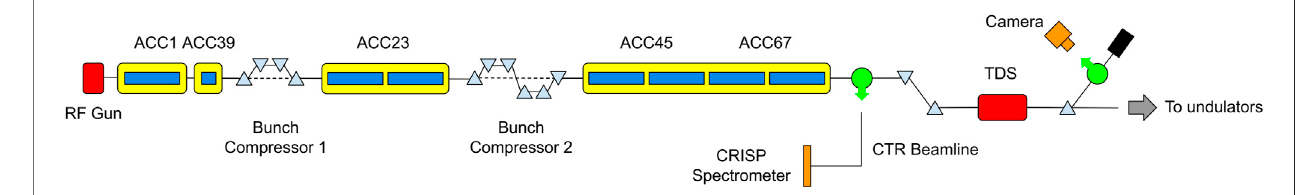
FIGURE 2 | Schematic of the FLASH1 beamline. Components are not to scale. ACC1, ACC23, ACC45 and ACC67 are 1.3 GHz cryomodules which boost the electron energy. ACC39 is a 3.9 GHz cryomodule which linearizes the LPS before the fi rst bunch compression stage. The CTR radiation is generated by de fl ecting